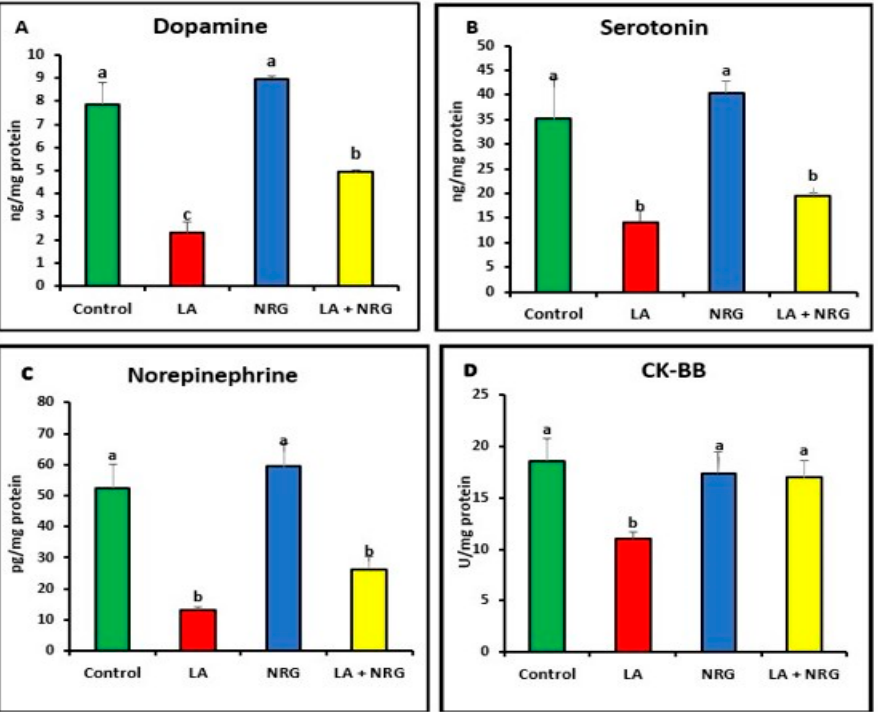
Figure 3. Brain neurotransmitters: ( A ) dopamine (ng/mg protein), ( B ) serotonin (ng/mg protein), ( C ) norepinephrine (pg/mg protein), and ( D ) CK-BB (U/mg/protein) in the different experimental groups at the 4th week of treatment of LA-intoxicated rats with NRG (mean ± SE). The means in each chart with different superscripts are significantly different ( p < 0.05). CK-BB: creatine kinase brain band isoenzyme. a for the high value; b, for intermediate values between a and c; while c for the lower value.